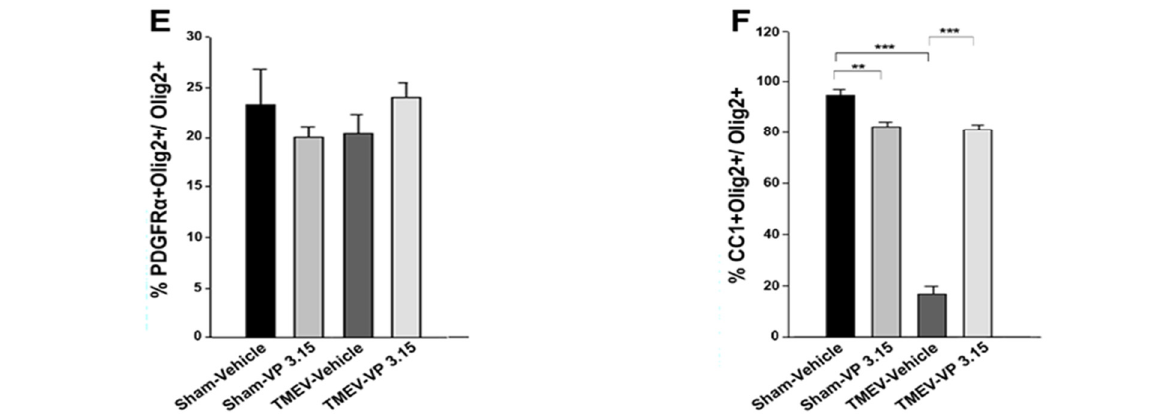
Figure 4. The VP3.15 promotes the presence of mature oligodendrocytes in spinal cord. ( A – D ): Detailed views of the spinal cords of vehicle and VP3.15-treated mice, labeled for PDGFR α (green), Olig2 (red), CC1 (grey) and merged includes nuclei (Hoechst; blue). Scale bar represents 50 µ m. ( E , F ): Graphs are showing the significant increase in the percentage of PDGFR α + Olig2 + cells ( E ) and Olig2 + CC1 + cells ( F ) after the treatment with VP3.15 compared to the vehicle. The statistical analysis was performed using the Student’s t test, with the following values: ** p < 0.01 Sham versus TMEV-